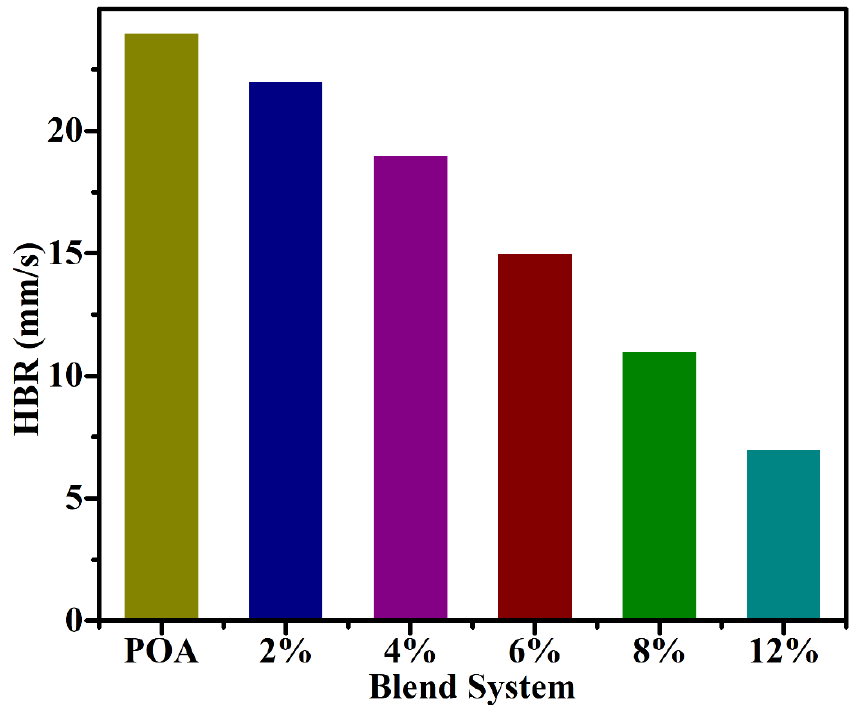
Table 2. The horizontal burning rates for MMT/POA nanocomposite.